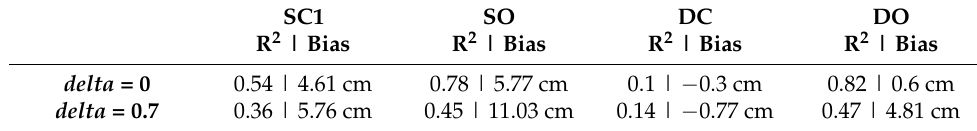
Table 3. Comparison of wave statistics when applying delta = 0 and delta = 0.7 based on the coefficient of determination (R 2 ) and the Bias for each hydrodynamic condition. SC1 SO DC DO R 2 | Bias R 2 | Bias R 2 | Bias R 2 | Bias delta = 0 0.54 | 4.61 cm 0.78 | 5.77 cm